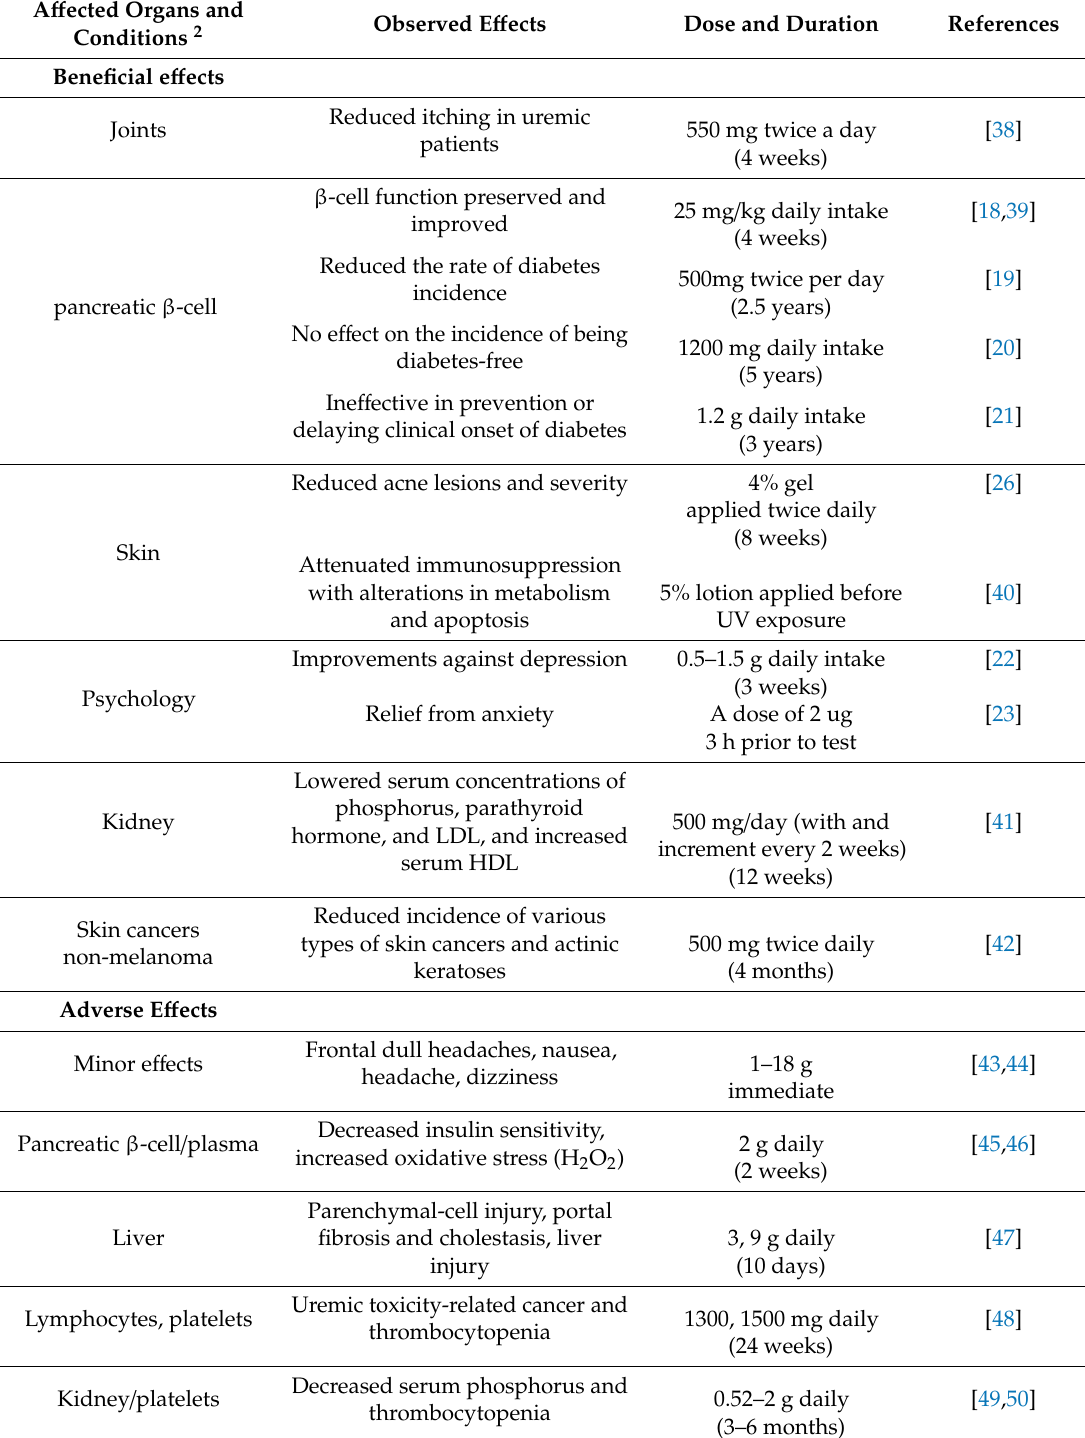
Table 2. Positive and negative e ff ects of NAM shown in human studies 1